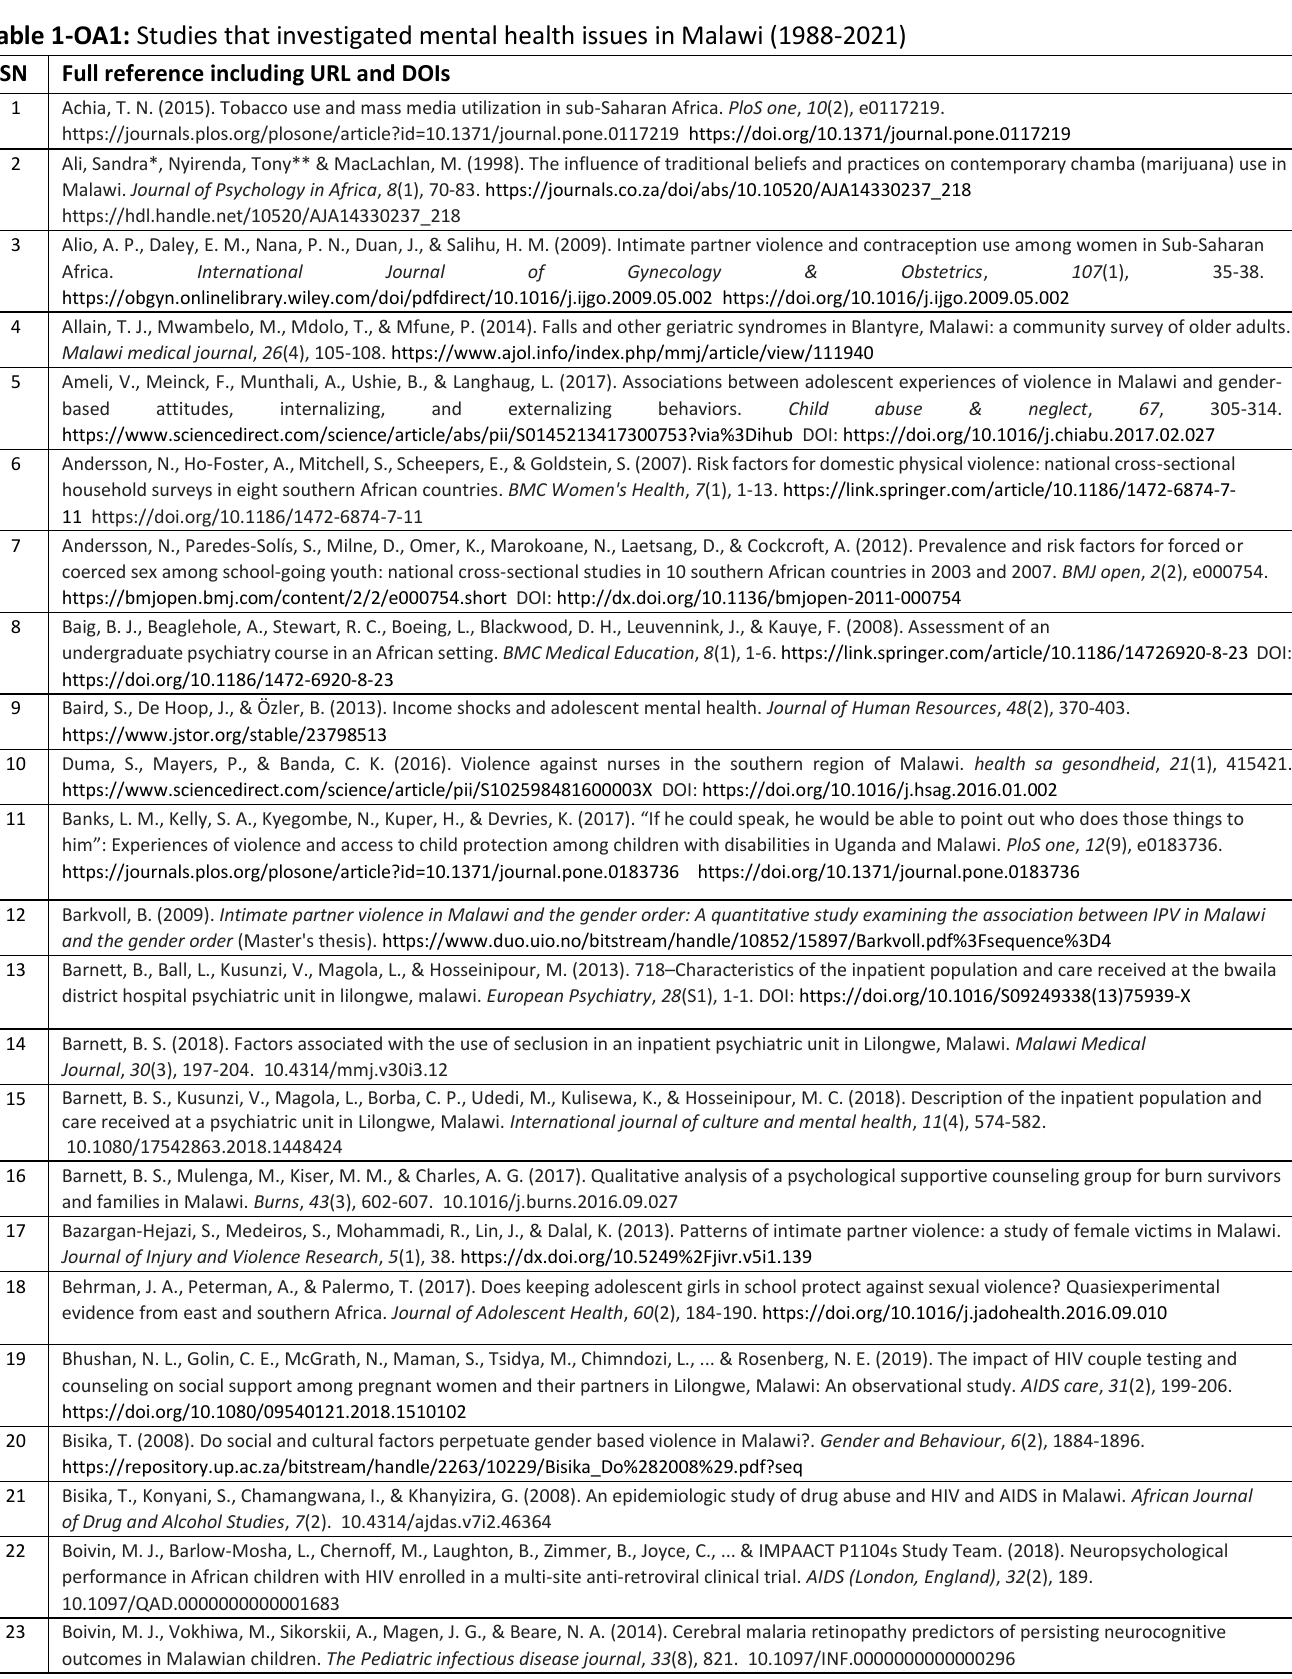
Table 1-OA1: Studies that investigated mental health issues in Malawi (1988-2021) SN Full reference including URL and